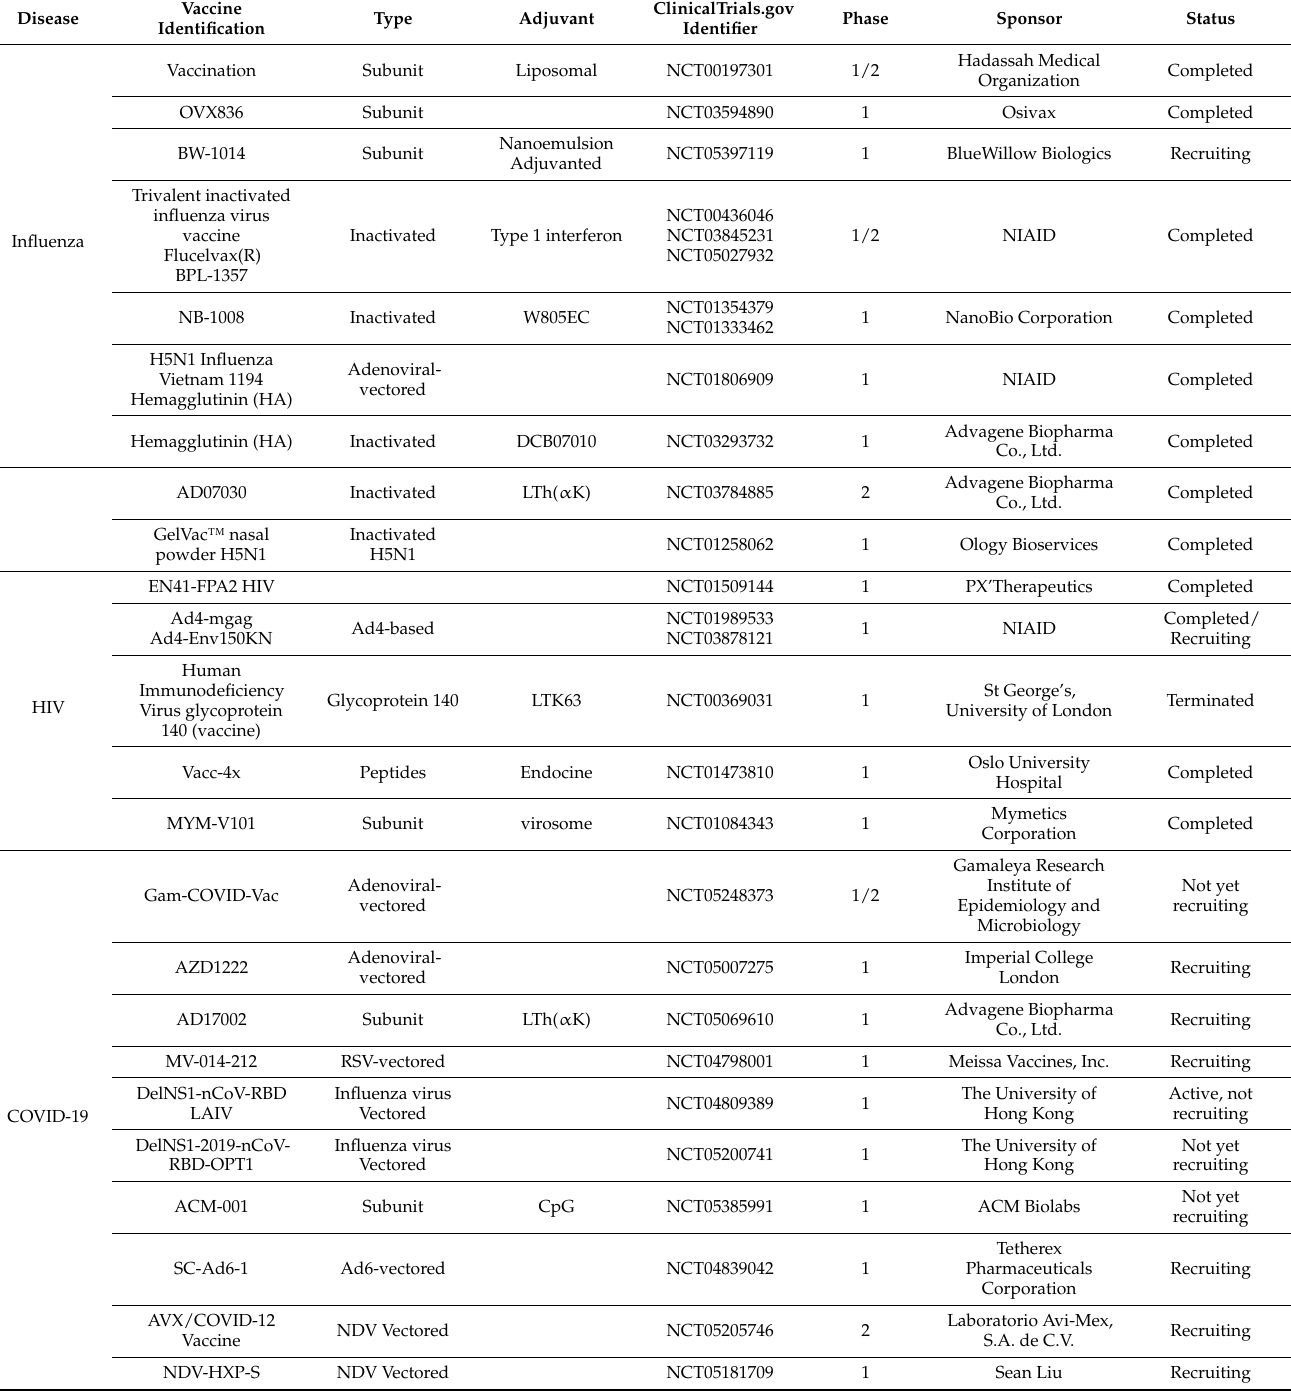
Table 2. Clinical progress in the development of peptide, subunit, inactivated, and viral vector-based nasal